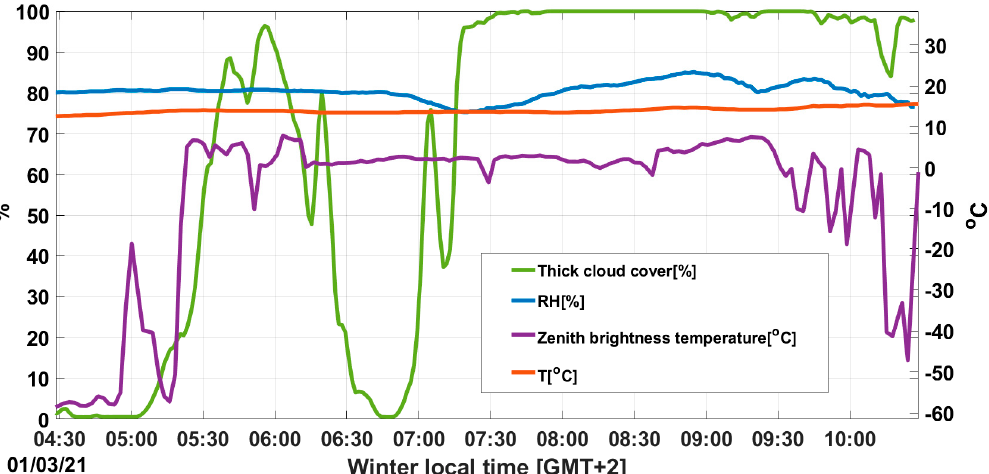
Figure 11. Cloud cover and zenith brightness temperature report during 1 March 2021, calculated from WSI data. The relative humidity and the air temperature are obtained from the sensors embedded in Asis1i.